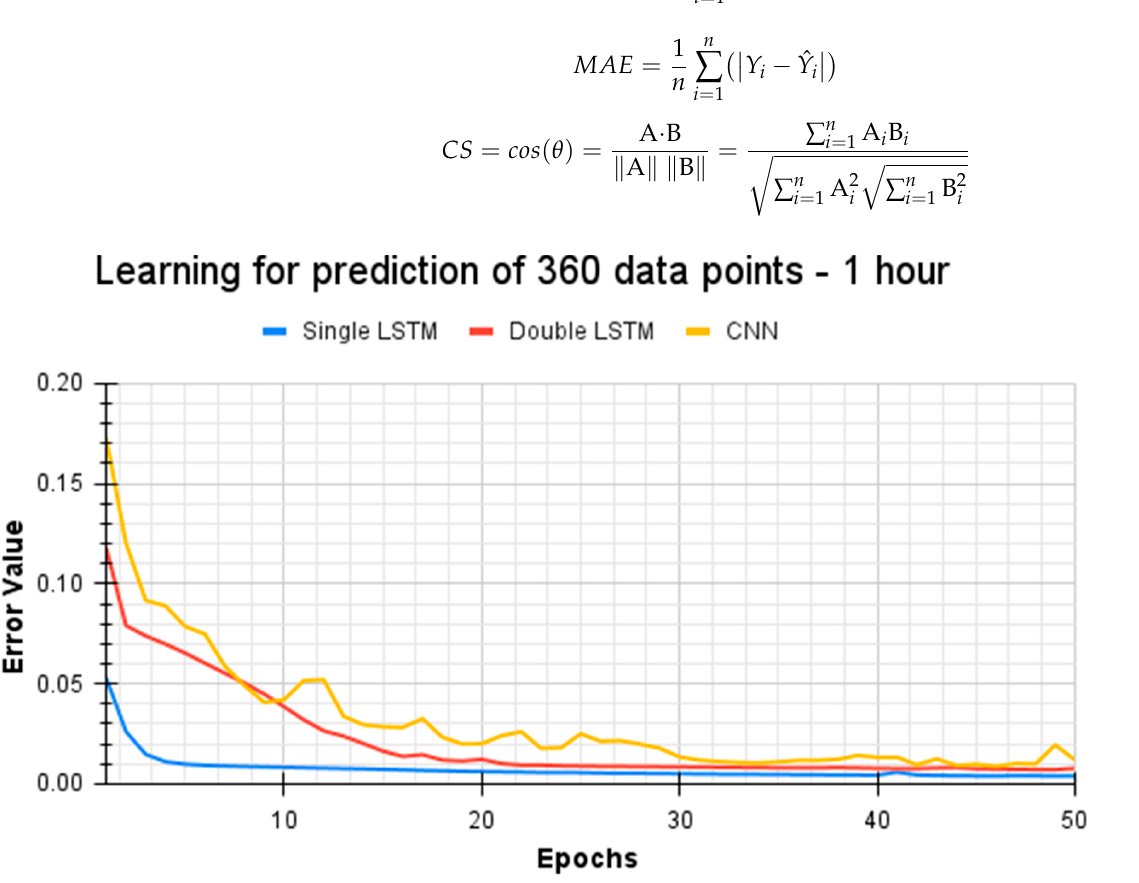
Figure 6. Comparison of the learning processes of different types of LSTM and CNN networks in the 1 h forecasting horizon: X -axis—next epochs, Y -axis—error level.